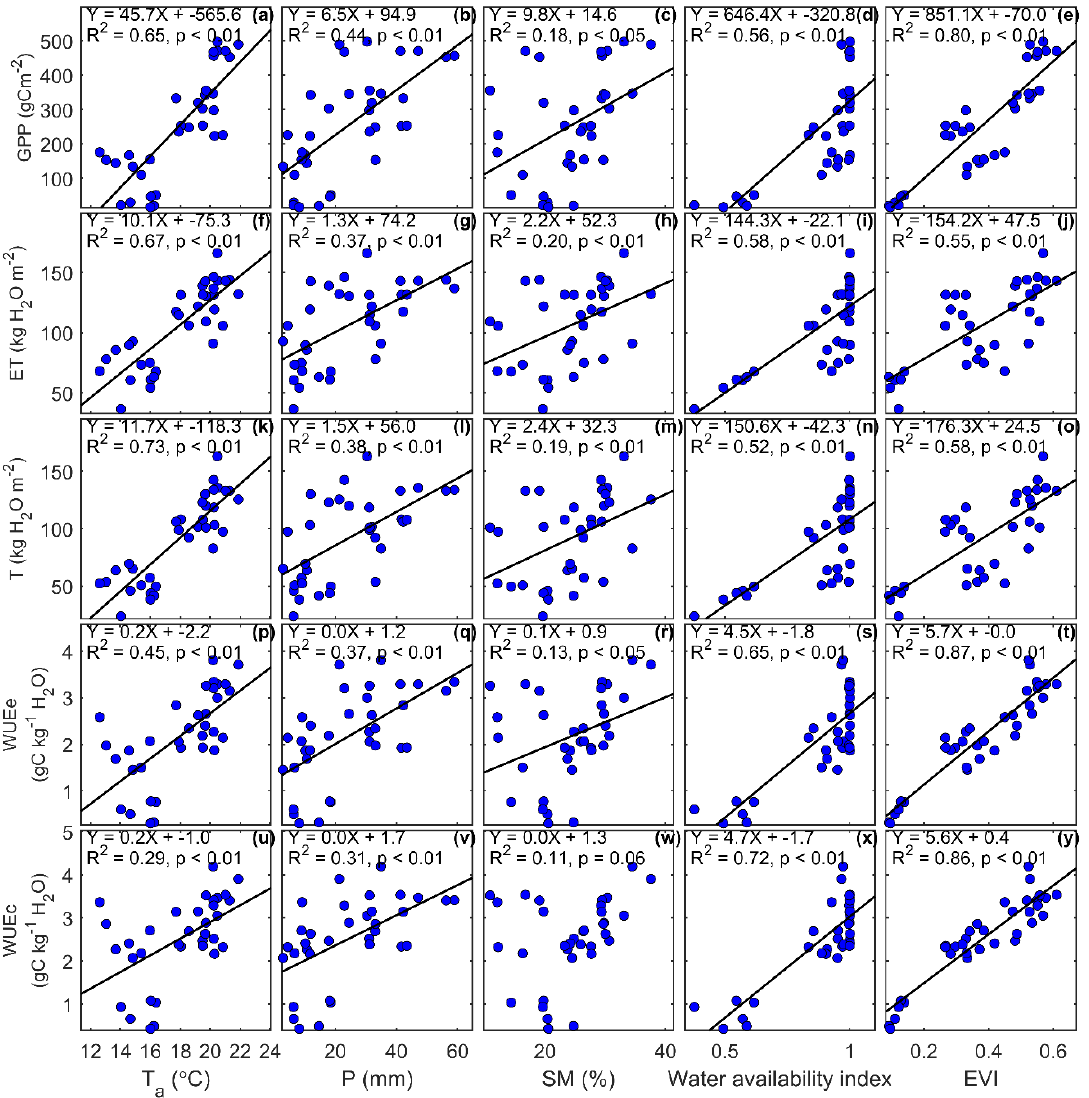
Figure 9. Relationship of monthly gross primary production (GPP)( a – e ), evapotranspiration (ET)( f – j ), transpiration (T)( k – o ), water use efficiency at ecosystem level (WUEe)( p – t ) and canopy level (WUEc)( u – y ) with environment variables that including monthly mean air temperature (Ta), precipitation (P), soil moisture at 4 cm layer (SM), water availability index, and EVI during the growing seasons (i.e., periods from May to September).